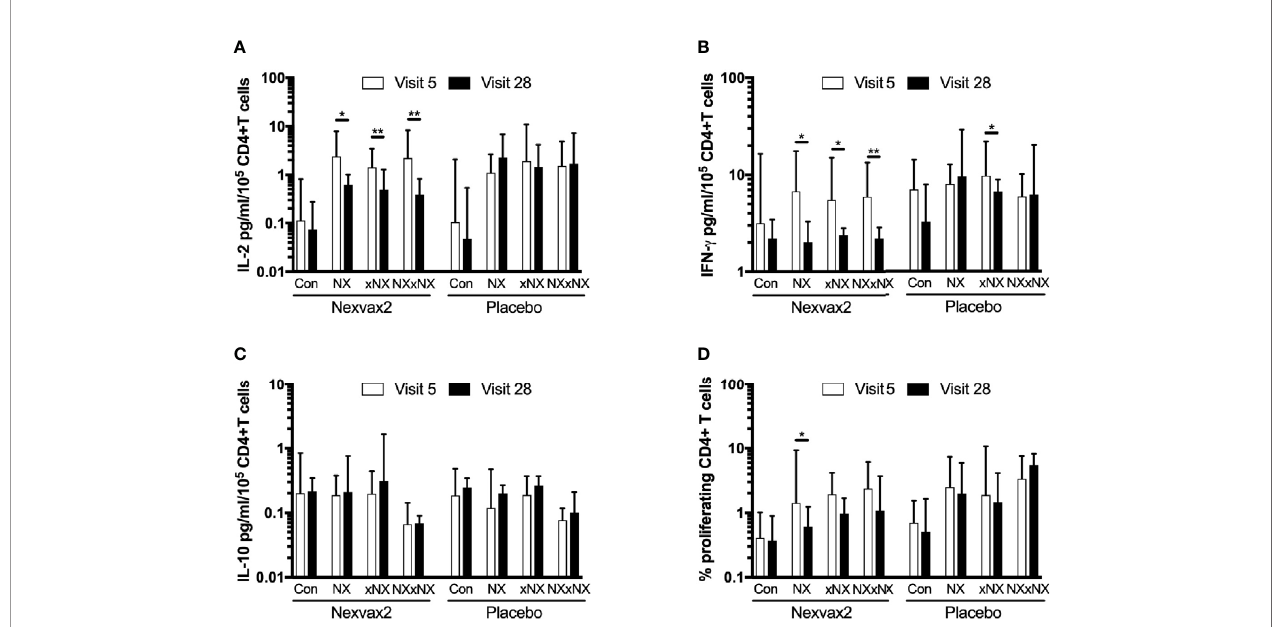
FIGURE 8 | Change in gluten peptide pool-stimulated whole blood CRA (A – C) and CD4+ T cell proliferation measured by 8-day CTV-dye dilution assay (D) over 12 weeks from before treatment at Visit 5 to Visit 28 during maintenance treatment in patients treated with Nexvax2 (n = 12) or placebo (n = 9) in the RESET CeD Study. Medians and interquartile ranges are indicated. Wilcoxon signed-rank test was used to compare Visit 5 to Visit 28; statistical signi fi cance is indicated by *p < 0.05, or **p <